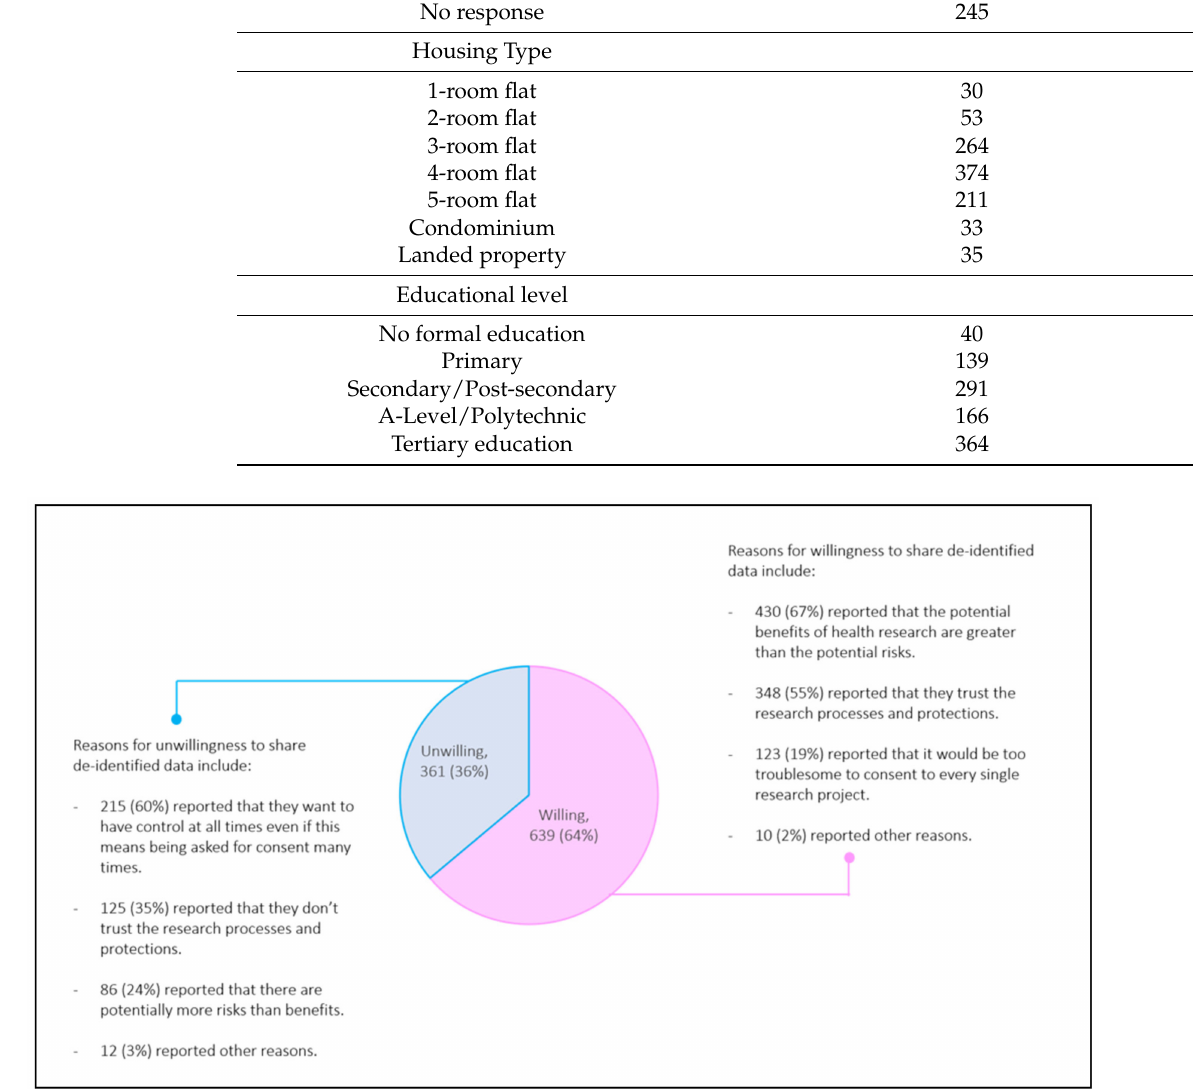
Figure 1. Willingness to share de-identified data for Institutional Review Board approved health research without needing consent for each